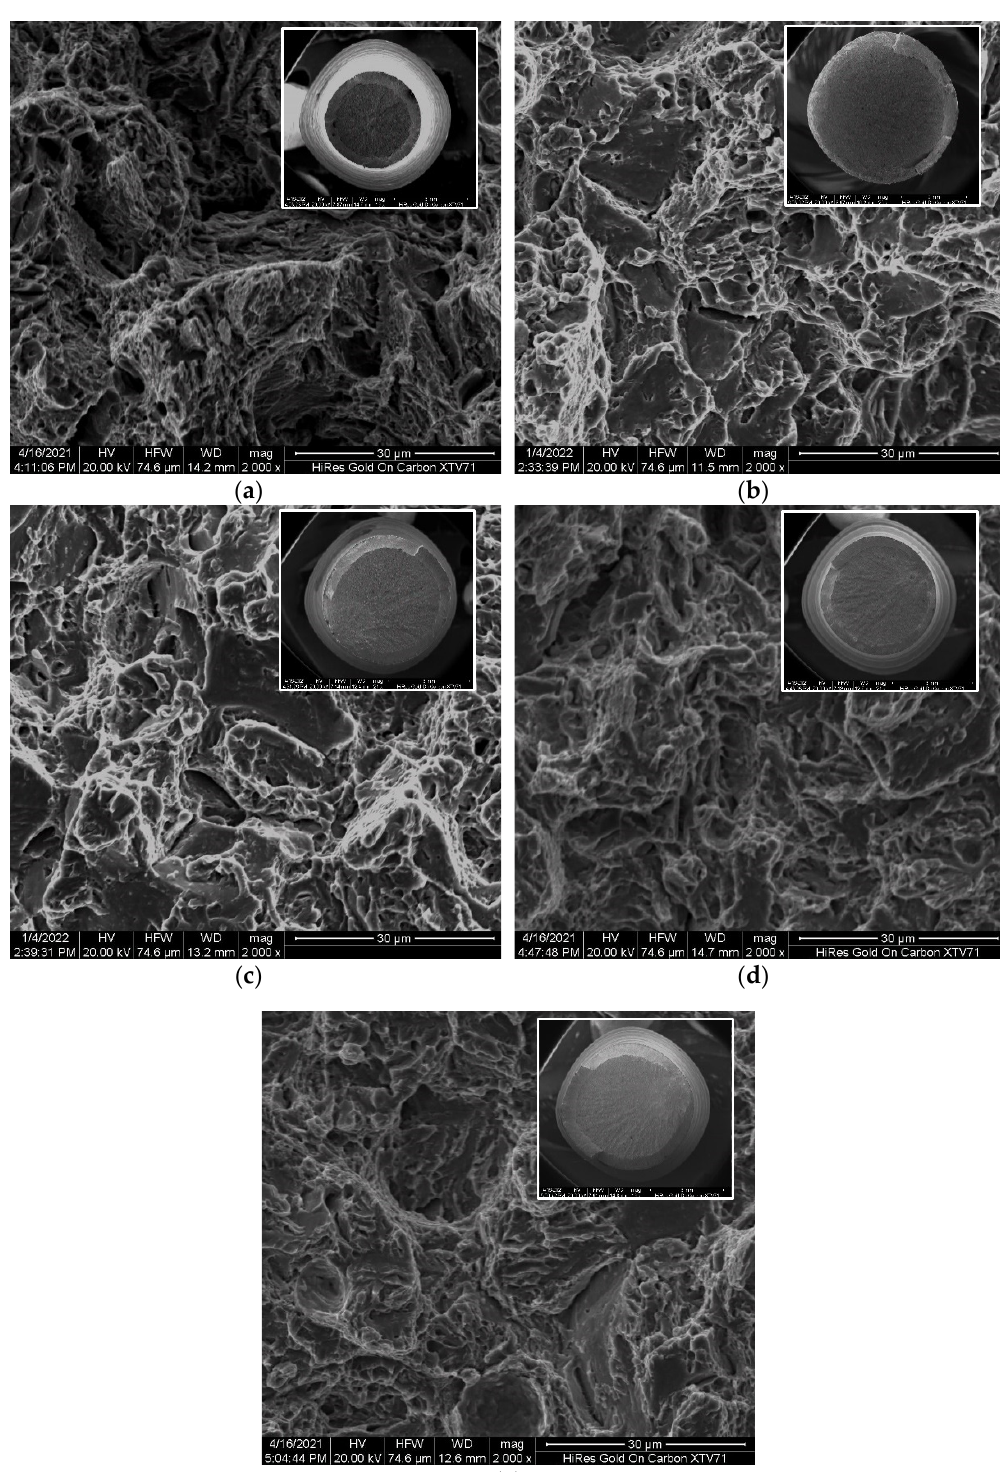
Figure 5. Tensile fracture morphology of material B. ( a ) Normal strain rate tensile test without hy- drogen charging; ( b ) Hydrogen filling 0.5 h slow strain rate tensile test; ( c ) Hydrogen filling 1.0 h slow strain rate tensile test; ( d ) Hydrogen filling 1.5 h slow strain rate tensile test; ( e ) Hydrogen filling 2.0 h slow strain rate tensile test.